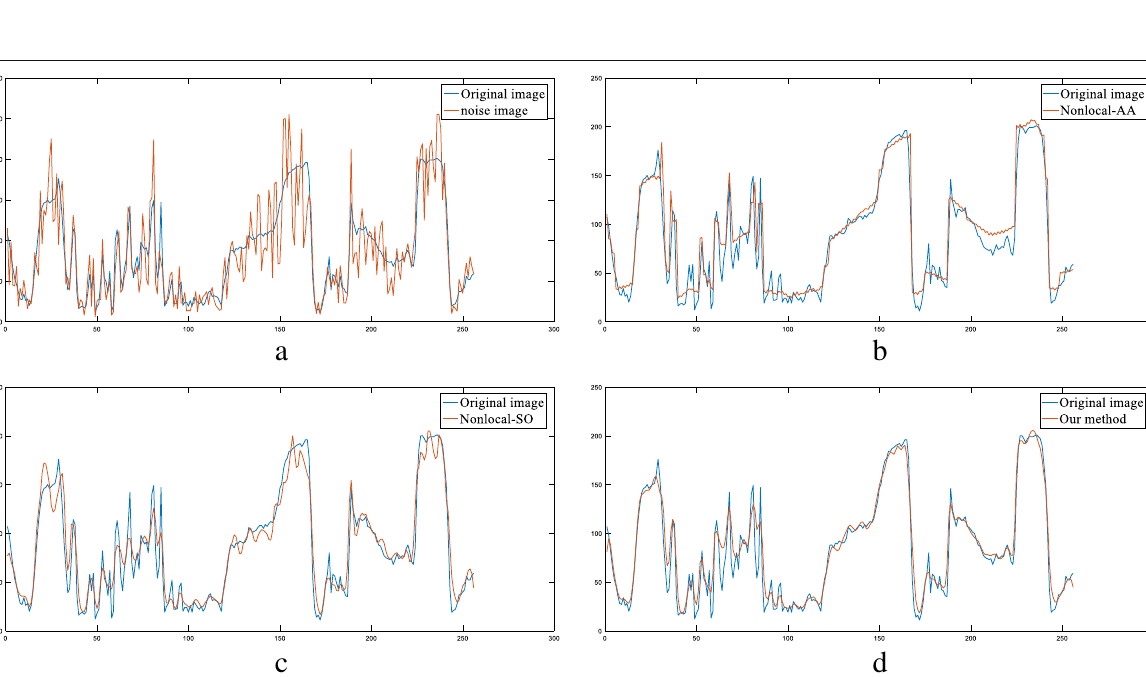
Fig. 3 The 200th lines of the clean, noisy, and deblurred images of different methods. a Noise and clean lines. b Deblurred line by nonlocal-AA method. c Deblurred line by nonlocal SO-method. d Deblurred line by the proposed